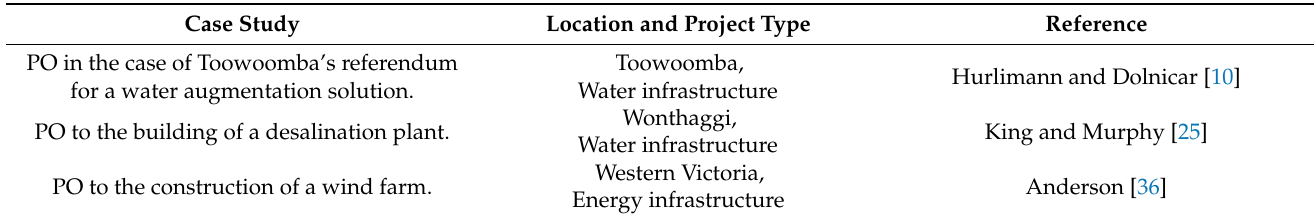
Table 1. Summary of Australian studies investigating POs to infrastructure